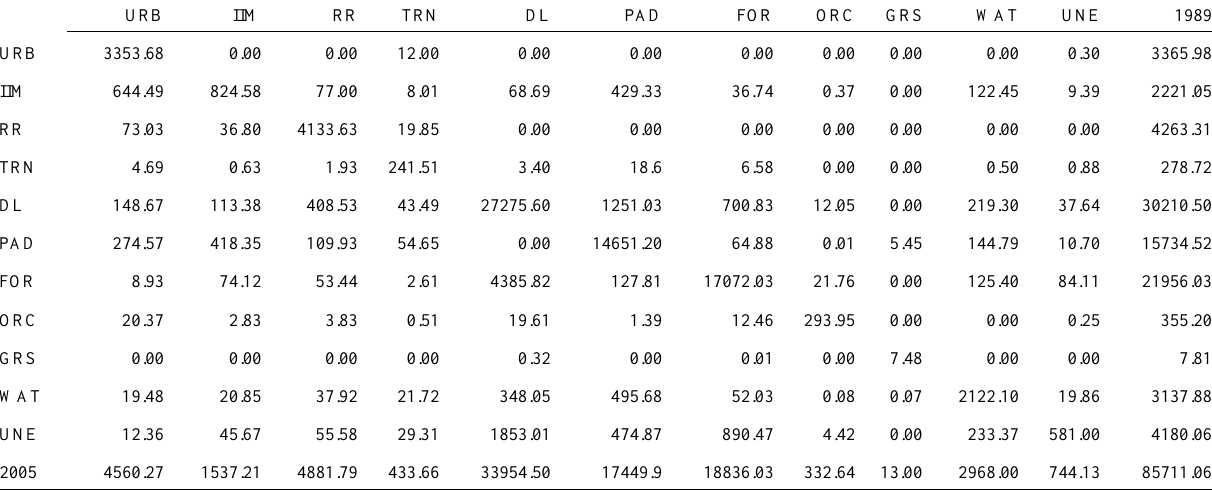
Table 3. Land use change matrix in Changyi district between 1989 and 2005